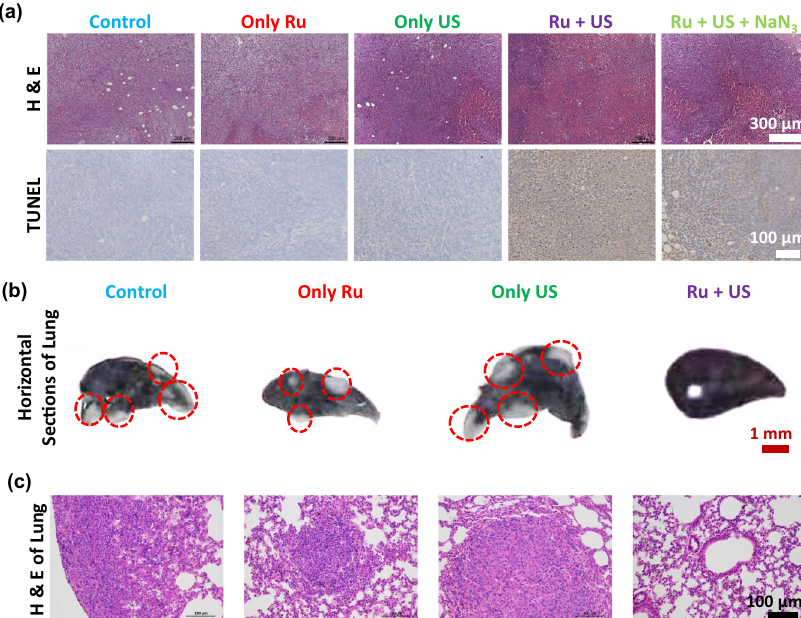
Fig. 6 Tumor histology and lung metastasis examination. a Microscopy photos of H&E and TUNEL stained tumor slices. Tumors tissue were collected from mice at 24 h post various treatments. The experiment was repeated three times independently with similar results. b Photos of horizontal sections of India ink stained lungs were collected from mice at 40 day post various treatments. Spontaneous pulmonary breast cancer metastasis sites are pointed out by red circles. c Microscopy images of H&E stained lung slices collected from different groups of mice at 40 day post various treatments. The experiment was repeated three times independently with similar results. US irradiation: 0.3 W cm − 2 , 3 MHz; Ru: [Ru(bpy) 3 ] 2 +